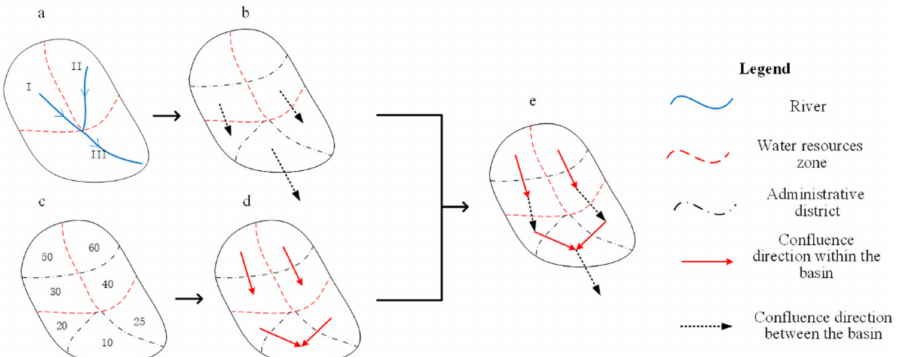
Figure 4. Confluence of socio-hydrological units and generation of generalized river network, ( a ) the water resource zones, ( b ) the confluence relationship between different water resources zones, ( c ) the elevation of the river buffer zone of the socio-hydrological unit, ( d ) the confluence relationship between the socio-hydrological units in the same water re-source zone, ( e ) the confluence relationships between all socio-hydrological